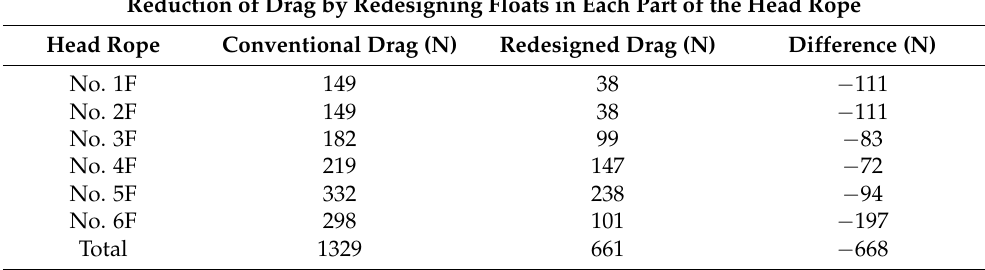
Figure 13. The arrangement of ground gear in redesigned by rearrangement of ground rope.